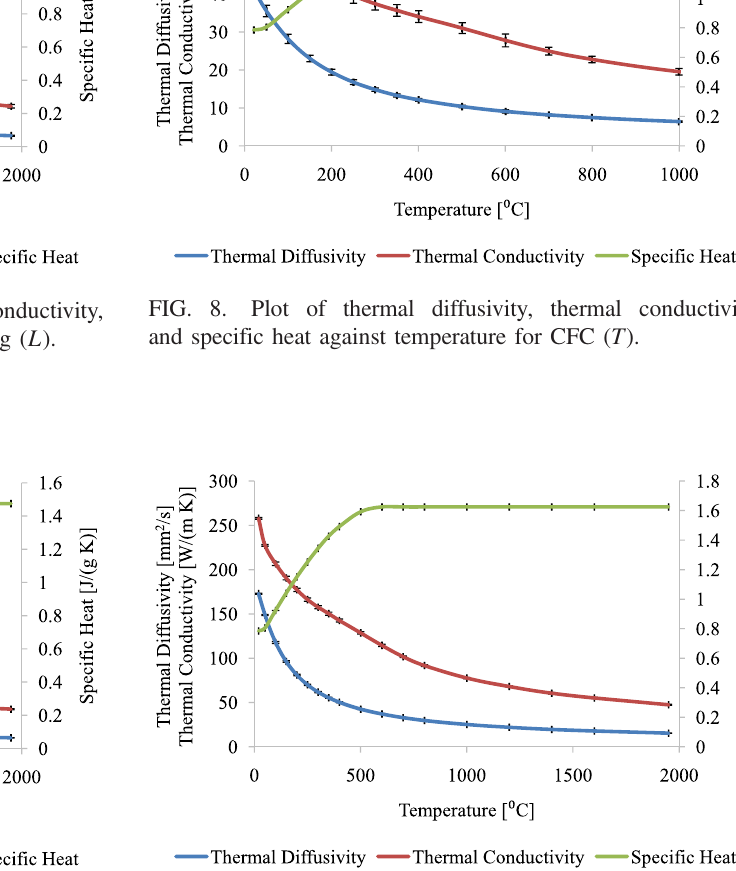
FIG. 9. Plot of thermal diffusivity, thermal conductivity, and specific heat against temperature for CFC along ( P